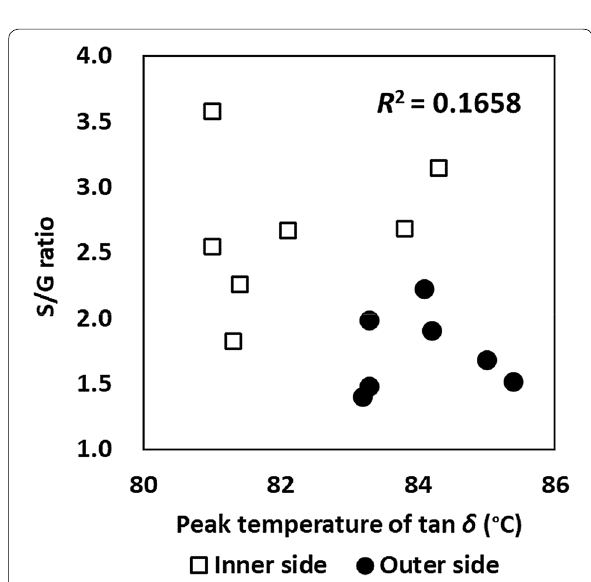
Fig. 9 Relationship between the peak temperature tan δ value and the S/G ratio of bamboo